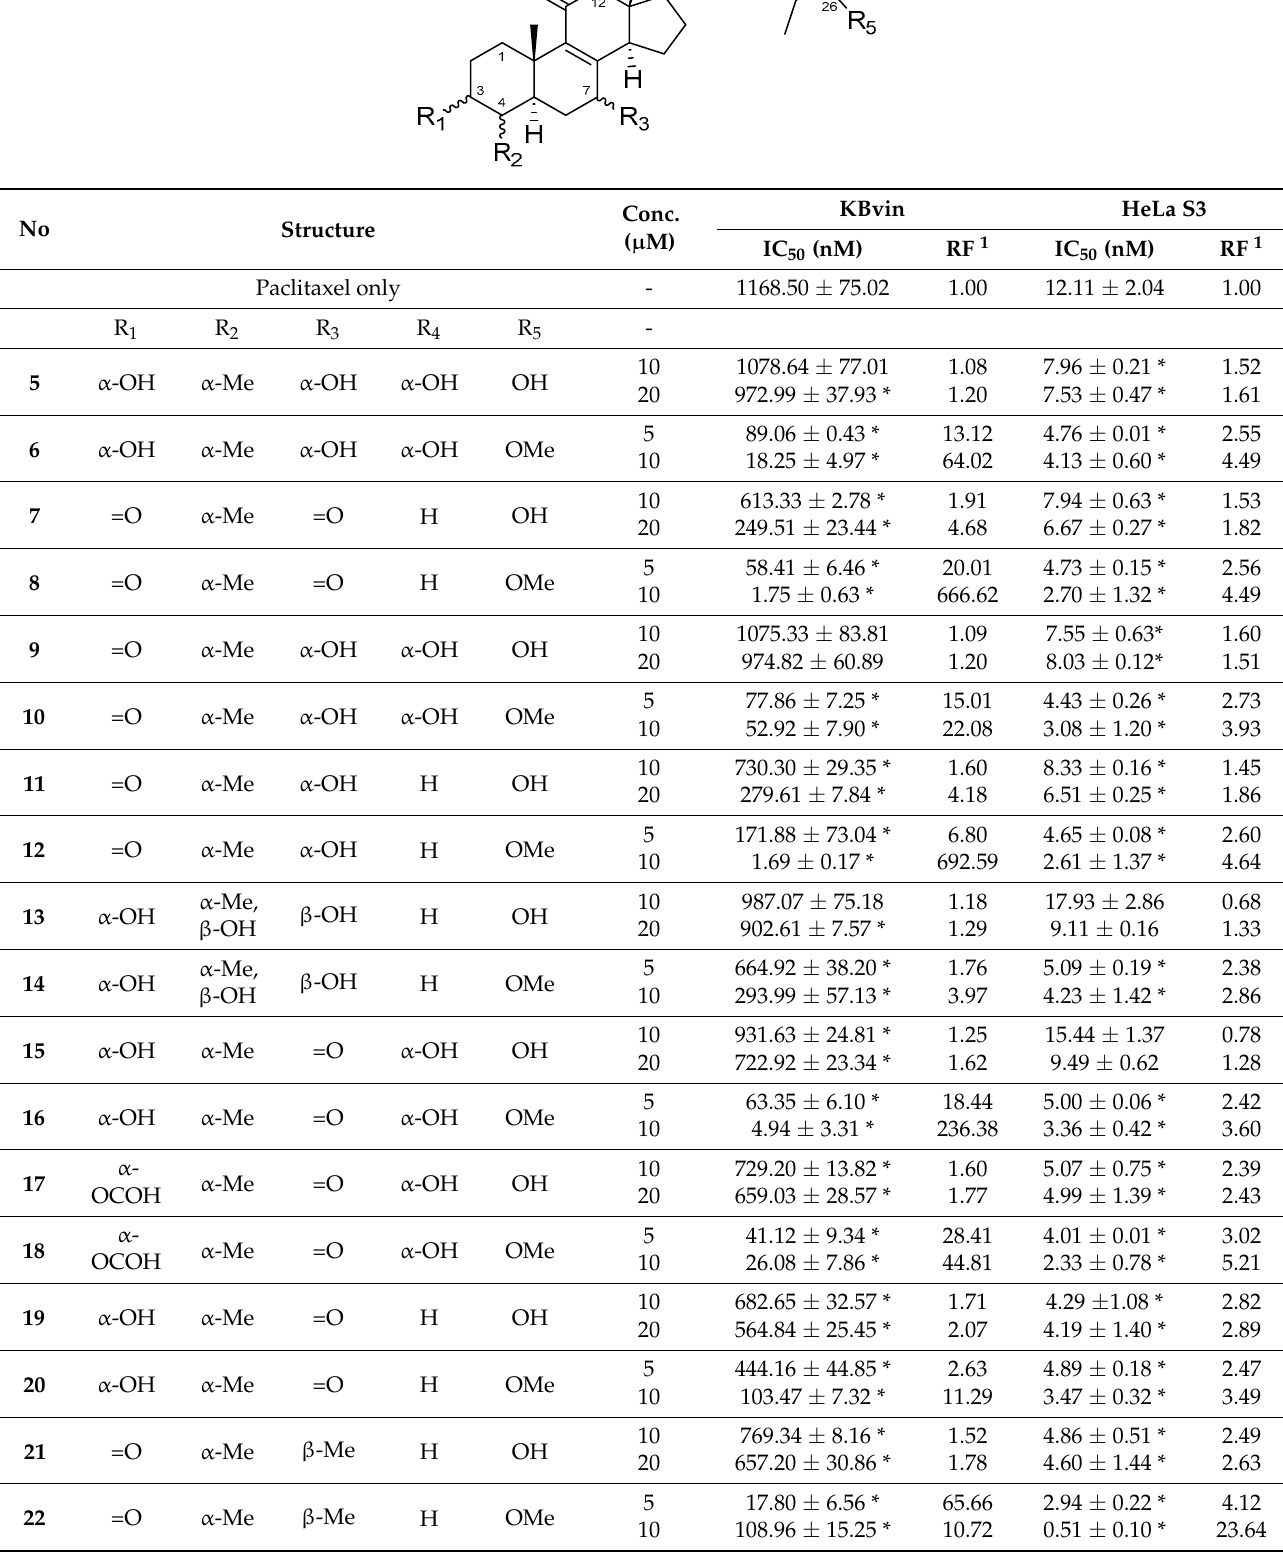
Table 3. Collateral sensitivity evaluation of the effects of zhankuic acid-type compounds and their methyl esters on the cytotoxicity of paclitaxel.